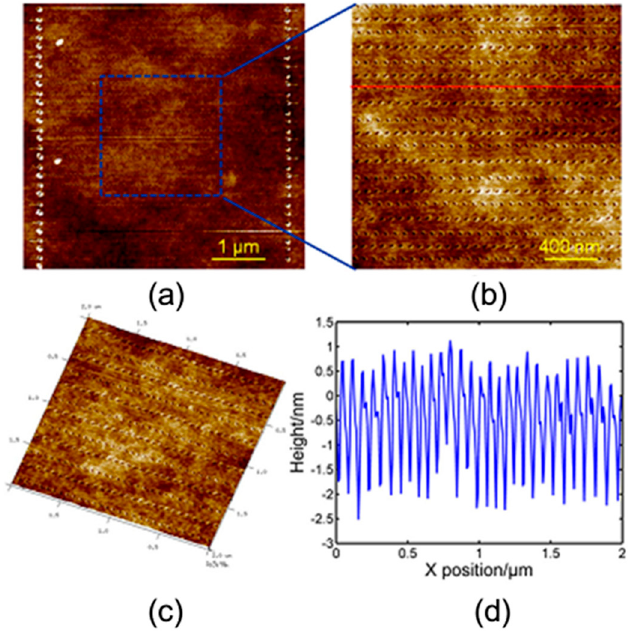
Figure 5. Surface morphology images of nano-pit arrays at a scanning speed of 400 µ m / s in the scan size of 5 µ m measured by AFM: ( a ) 2D images, ( b ) zoom-in image of figure ( a ) at a dimension of 2 µ m, ( c ) 3D image of ( b ), ( d ) cross-section of ( b ) [82] .